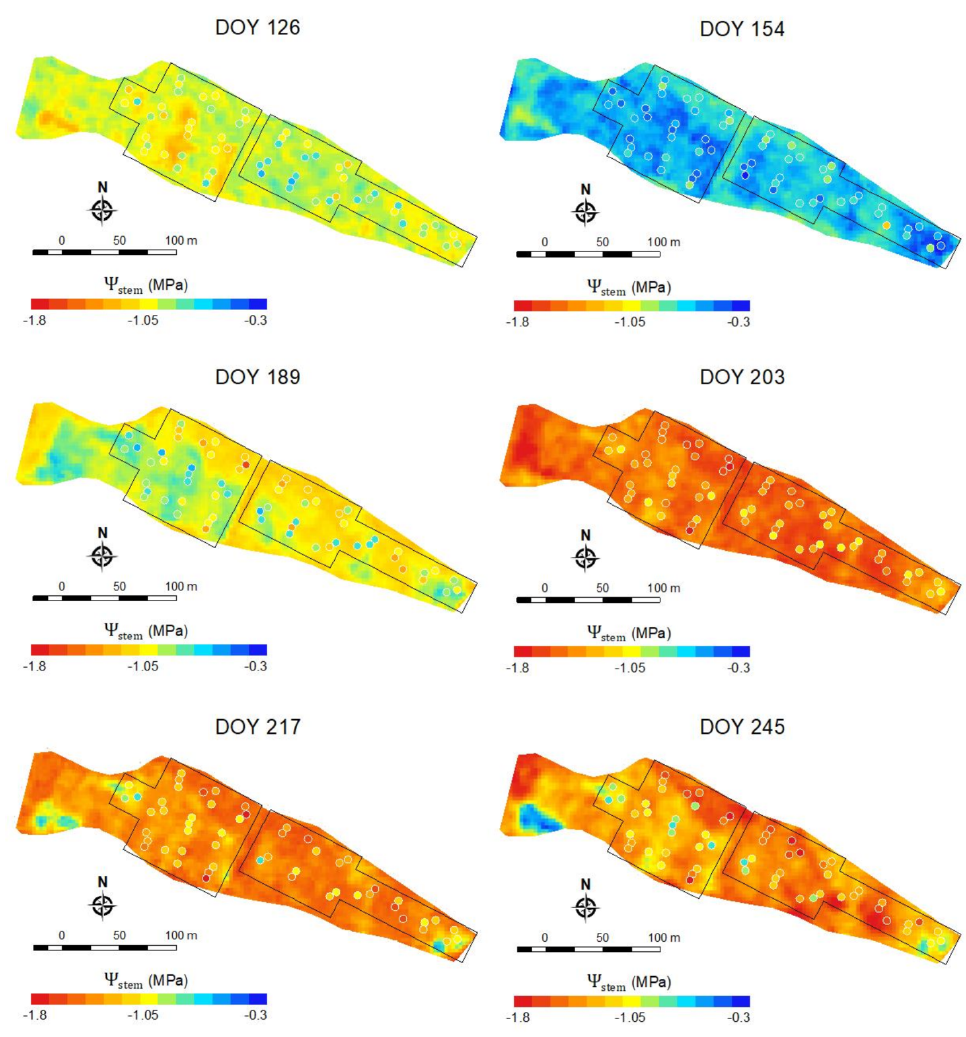
Figure 4. High-resolution Ψ stem maps of Mevo Beitar vineyard derived from MB-Mult (the multivariable regression model) using SAVI for selected weeks along the season. Plots Ψ stem measured values are also shown in circles. Note that all figures in this panel use the same legend and